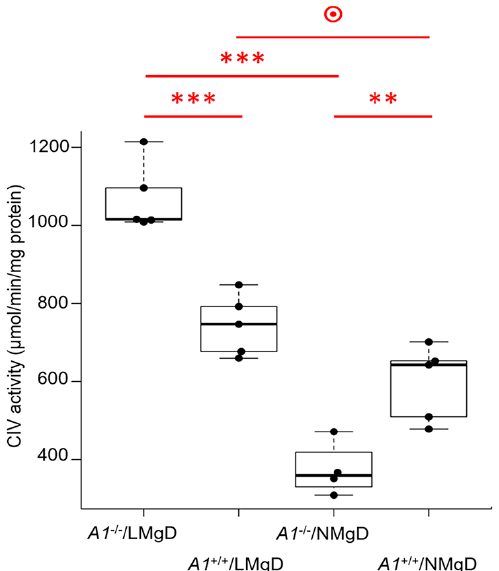
Figure A1. Post-hoc Tukey’s range test / CIV. The CIV activities presented as box-and-whisker plot overlaid with dot plot; dots represent raw input values for each analyzed group ( Slc41a1 − / − animals on LMgD, Slc41a1 +/+ animals on LMgD, Slc41a1 − / − animals on NMgD, and Slc41a1 +/+ animals on NMgD); ** p < 0.01, *** p < 0.001. Abbreviations: ⦿ , trend towards significance ( p < 0.1); A1 , Slc41a1 ; CIV, complex IV; LMgD, low Mg diet; NMgD, normal Mg diet.